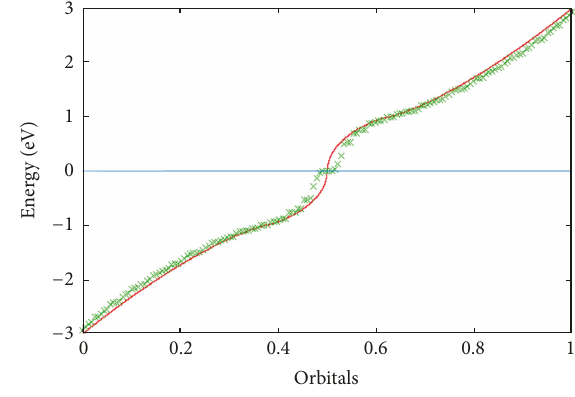
Figure 5: R 8 energy spectrum.